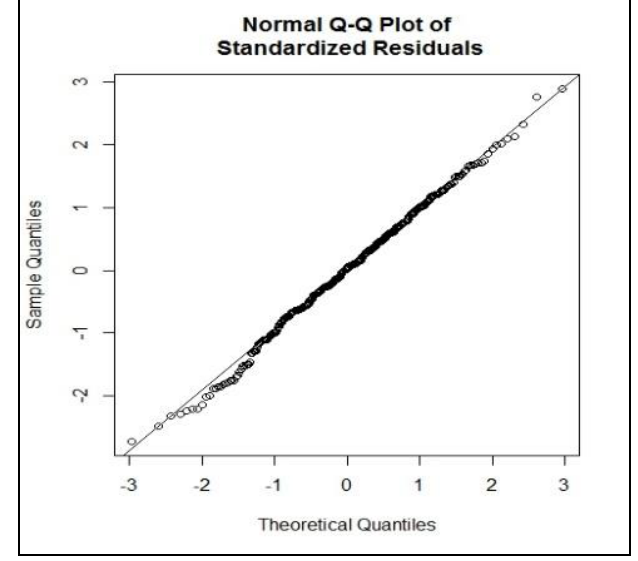
Figure 4. Q-Q plot of equation 4.